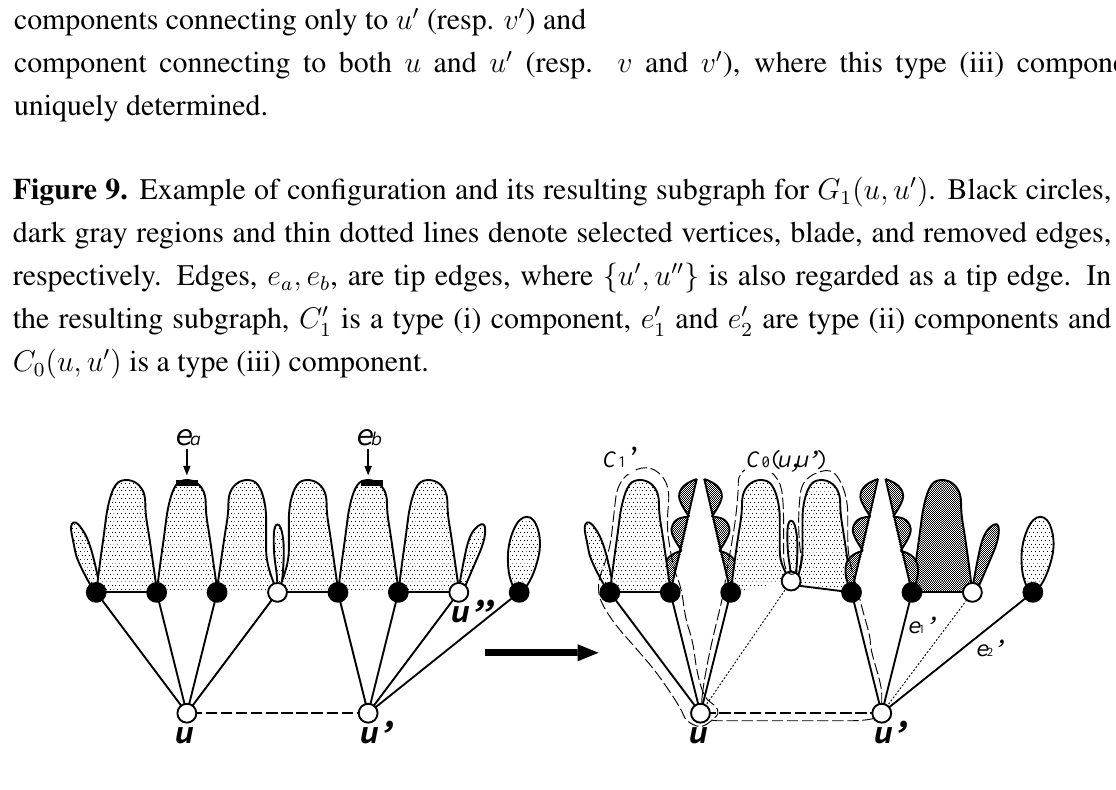
( u; u ′ ) . Black circles, 1